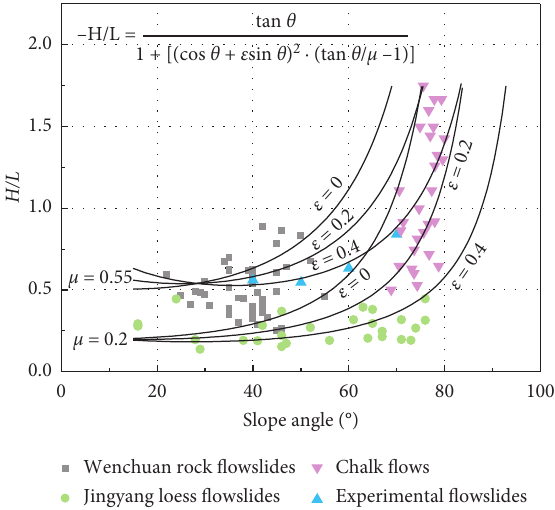
Figure 14: Comprehensive relationship between slope angle and apparent friction coefficient. Formula comes from Crosta